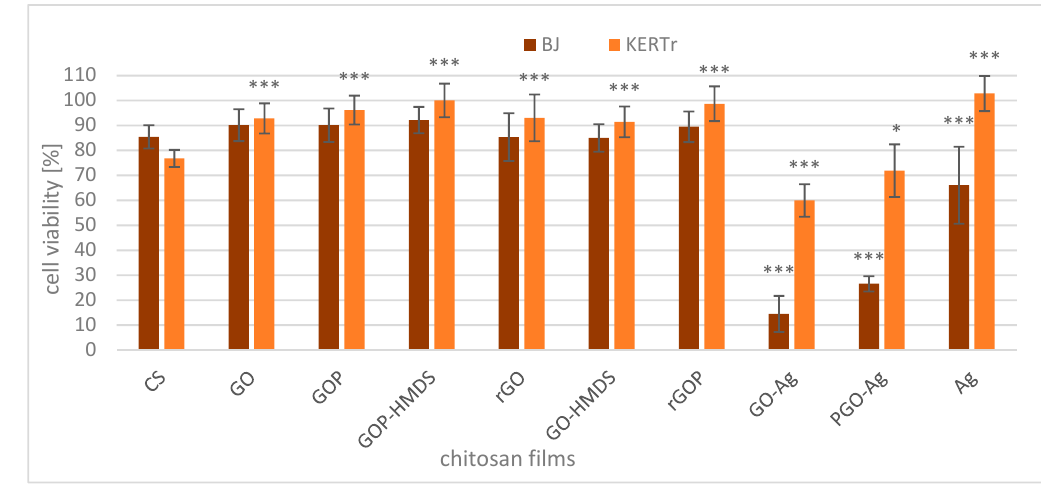
Figure 8. Viability of human fibroblast (BJ) and keratinocyte (KERTr) cells treated with chitosan and chitosan-graphene composites for 24 h. Cell viability was calculated as the percent ratio of absorbance of the samples to the referent control (untreated cells). The value from control group was set as 100%. Statistical significance is marked in relation to the chitosan nanocomposite (CS) ( n = 6, * p < 0.05, *** p < 0.001).